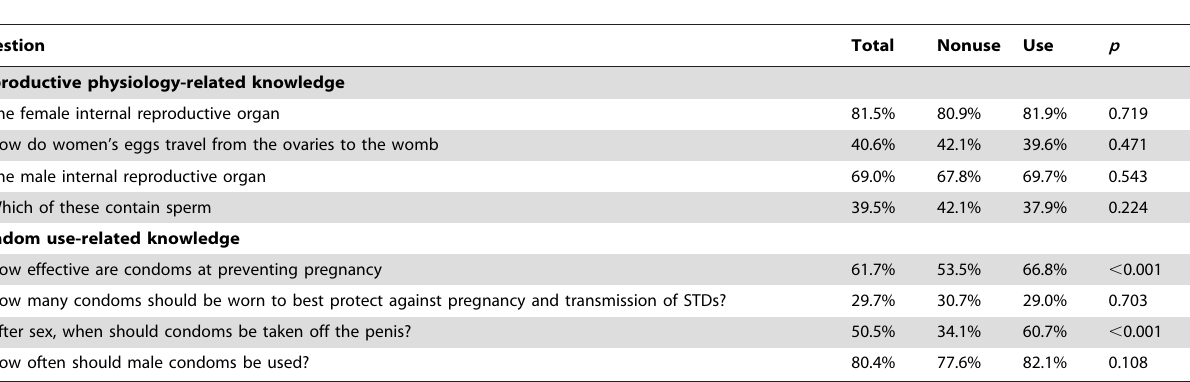
Table 1. Descriptions for reproductive health knowledge among male college students (individual items and percent correct).